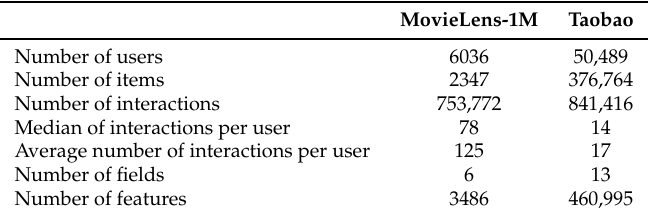
Table 2. Descriptive statistics for the datasets.